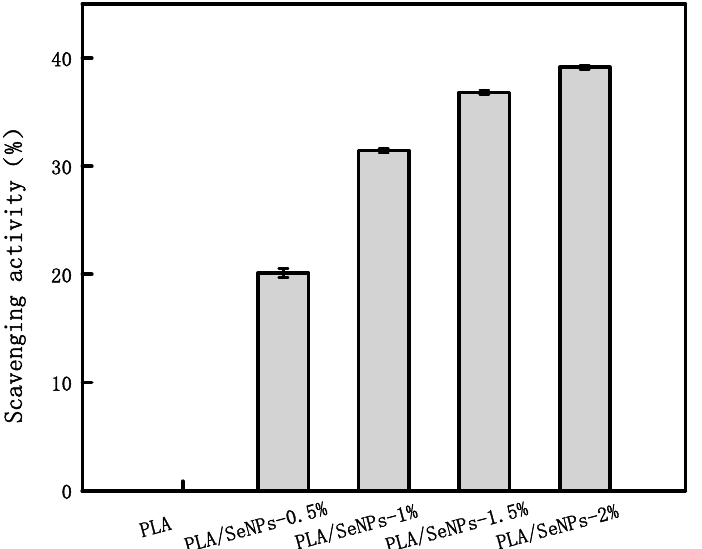
Figure 6. DPPH radical scavenging activities of different composite membranes. Each value represents mean ± standard deviation (SD) of triplicates.